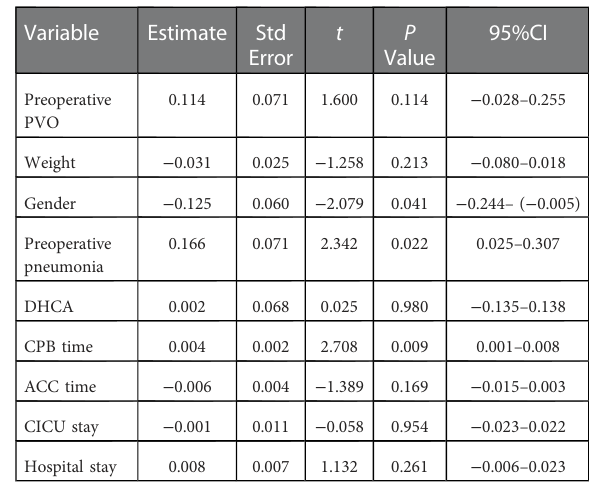
TABLE 4 Multiple linear regression model of factors associated With postoperative pulmonary vein fl ow